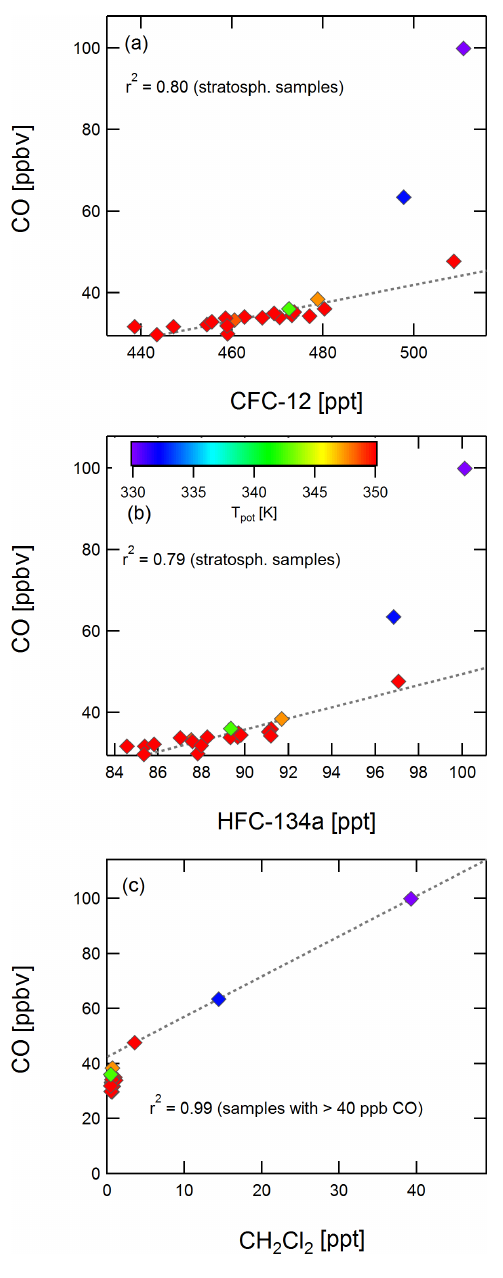
Figure 7. Correlation of CFC-12 (a) , HFC-134a (b) , and dichloromethane (c) with CO. Colour coding is by potential tem- perature. Values of r 2 are given for the correlation of stratospheric samples for CFC-12 and HFC-134a and for three samples with a CO mixing ratio above 40ppb in the case of